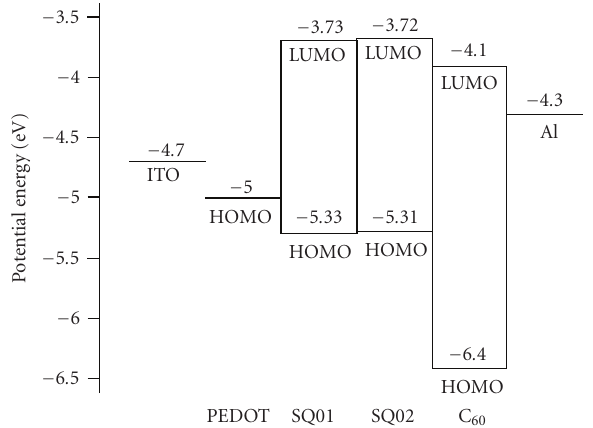
Figure 2: Energy level diagram of the organic materials and electrodes. The work function of Ca of − 2 . 9 eV is not shown in this